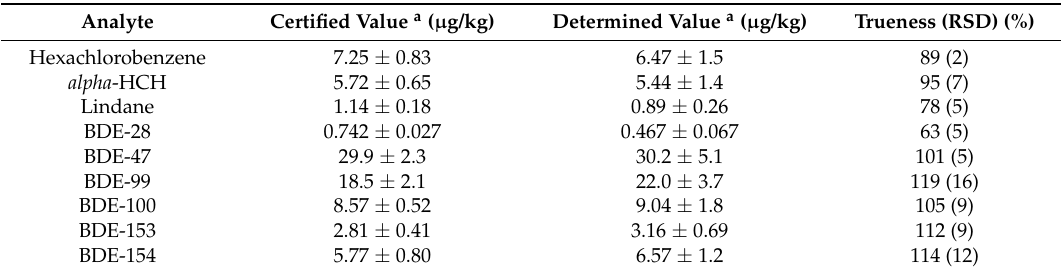
a Mean value ± expanded combined measurement uncertainty ( U r,tot ); n =